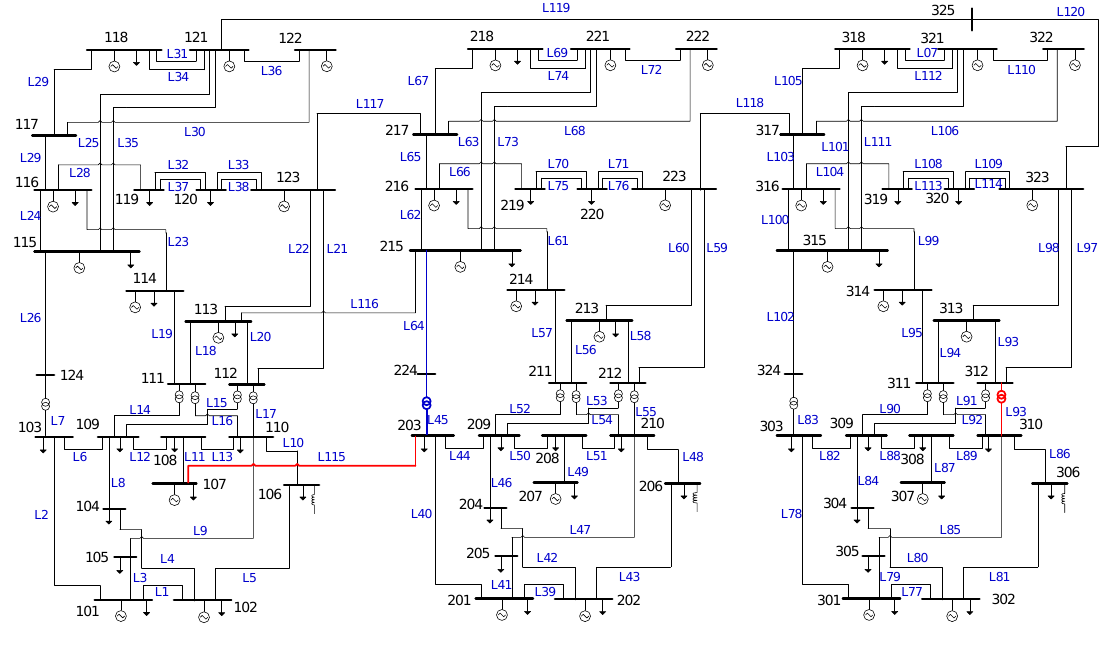
Figure 3. Test system under study (IEEE RTS-96). Table 1. Formulations of the SCUC problem.